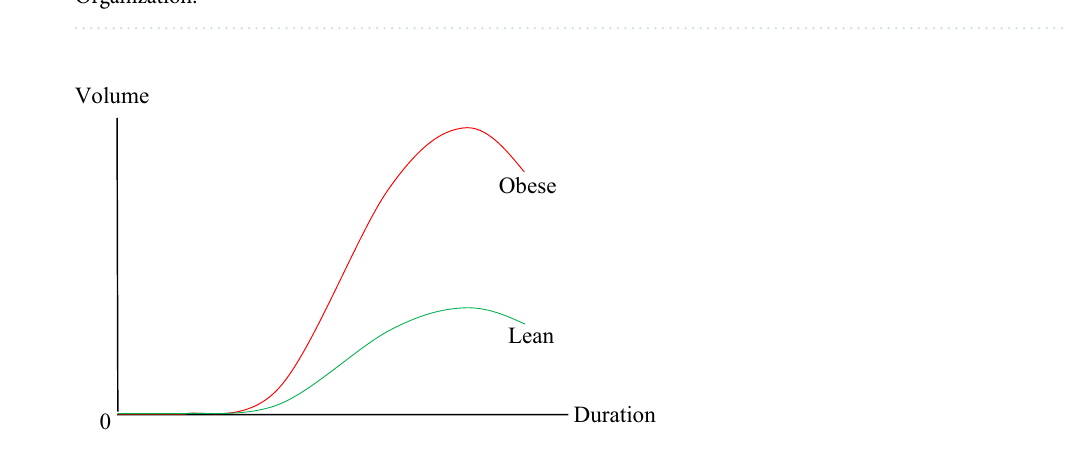
Figure 2. Global Distribution of Obese in Adult Population. Source: Global Health Observatory, World Health Organization.